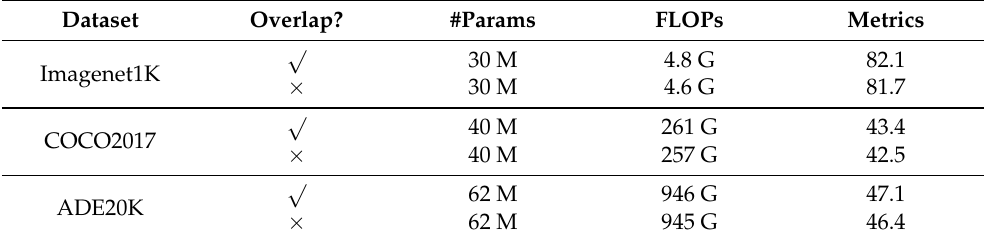
Table 6. Effectiveness of the proposed overlapping windows in the LSA module. Metrics on Imagenet1K is top-1 accuracy, on COCO2017 is AP b , and on ADE20K is mIoU.